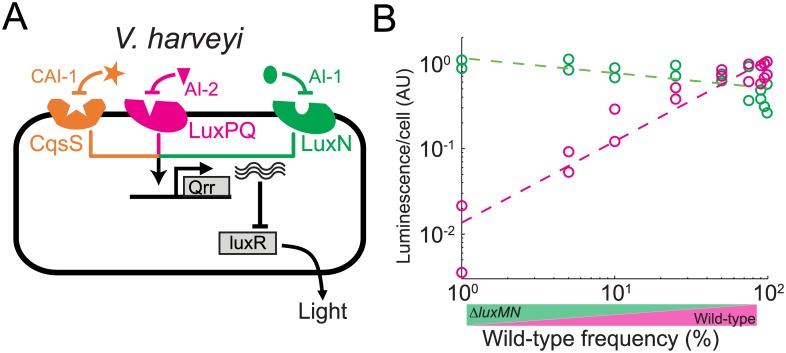
Facultative quorum-sensing response in V. harveyi.(A) Schematic structure of the architecture of the V. harveyi quorum-sensing network. (B) Quorum-sensing response in V. harveyi was measured using the natural quorum-sensing-dependent bioluminescence output. Shown is the bioluminescence per cell as a function of wild-type frequency, for the wild-type (magenta) and the luxMN mutant (green) during coculture of the two strains. Bioluminescence of each strain was measured by introducing a null mutation into the lux operon of the cocultured partner strain.